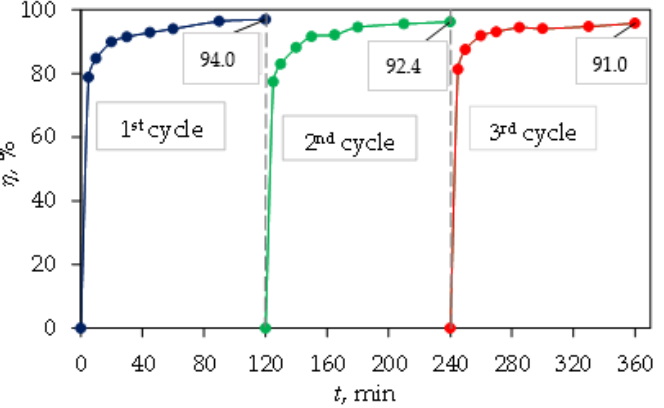
Figure 10. Reusability efficiencies of the ternary core–shell Fe 3 O 4 /SiO 2 /TiO 2 photocatalyst for three consecutive cycles.